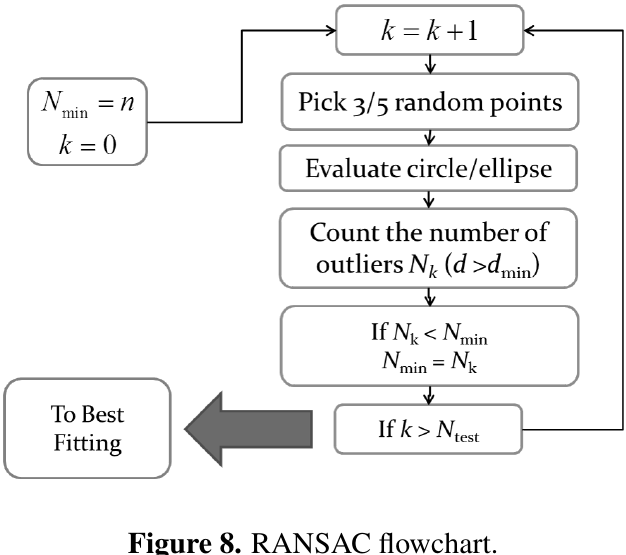
Figure 8. RANSAC